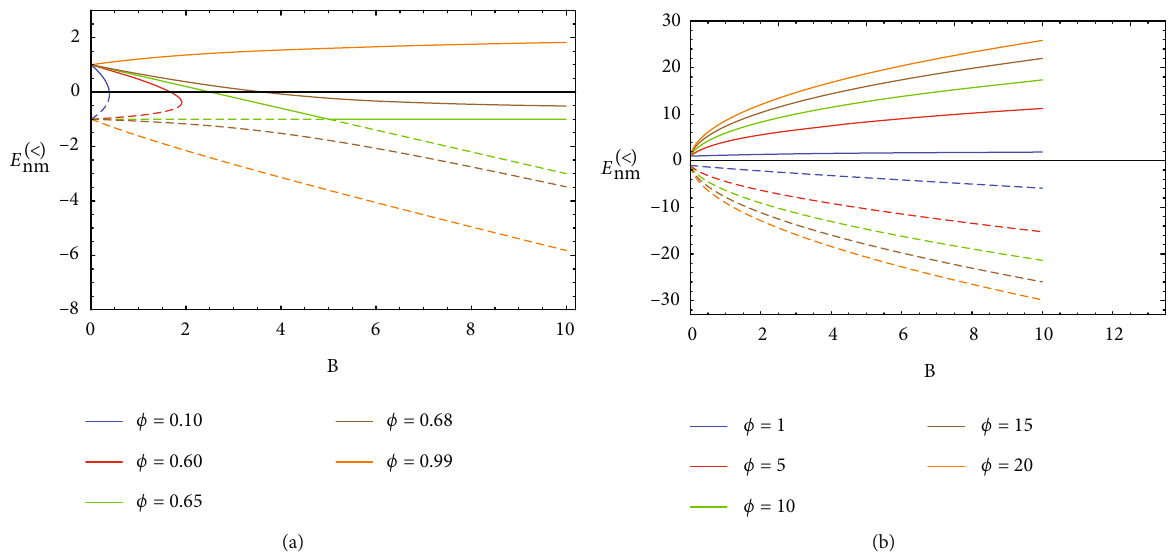
Figure 4: Sketch of the energy (Equation (71)) as a function of B for n = 1 , m = 1 , a = 0 : 1 , and α = 0 : 5 . In panel (a), we consider values of ϕ smaller than 1 while in panel (b), we use larger values. The physical implications due to the variation of ϕ on the energy spectrum are more evident for values of ϕ about 0 : 65 . For values of ϕ larger than 1 , the curves assume the same pro fi